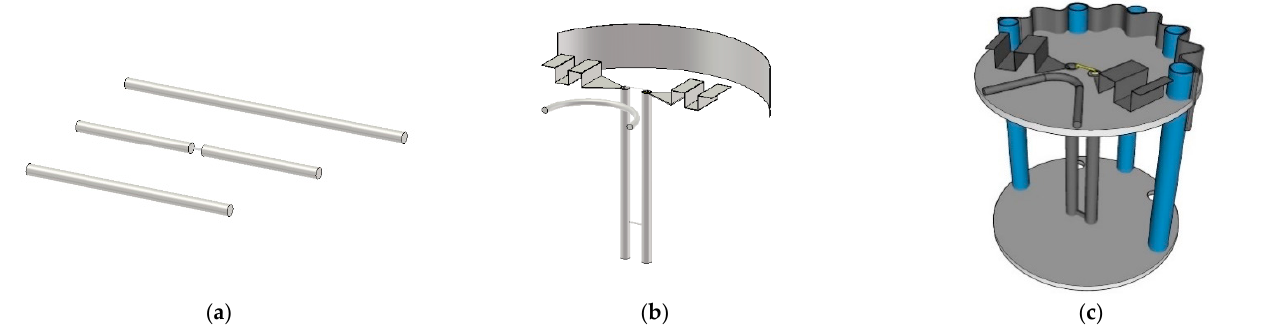
Figure 3. Conceptualization of the portable directional antenna scheme: ( a ) the Yagi-Uda antenna (model I), ( b ) the modified antenna with the U-shaped reflector and director (model II), and ( c ) the proposed portable antenna scheme (model III).